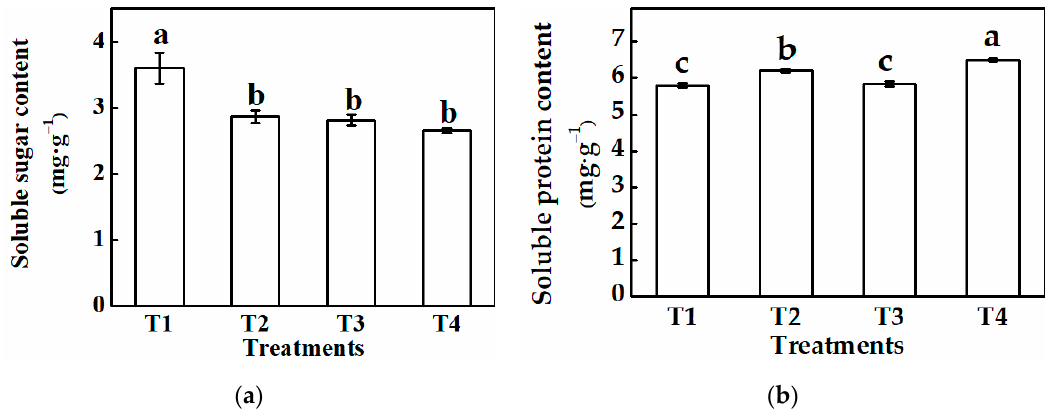
Figure 7. The effects of different light intensities and photoperiods on ( a ) soluble sugar and ( b ) soluble protein content of cucumber seedlings. Different letters indicate statistically significant differences among treatments ( p ≤ 0.05). Error bars show SEs ( n = 9).